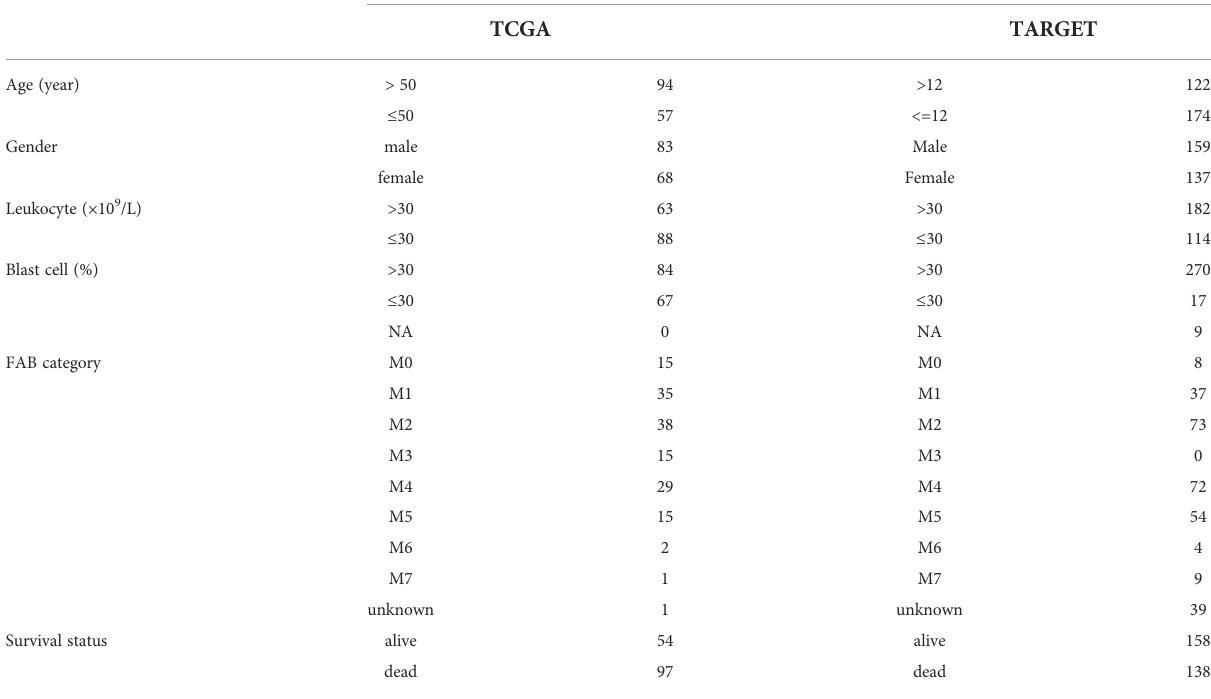
TABLE 1 Clinical characteristics of patients in TCGA and TARGET datasets.